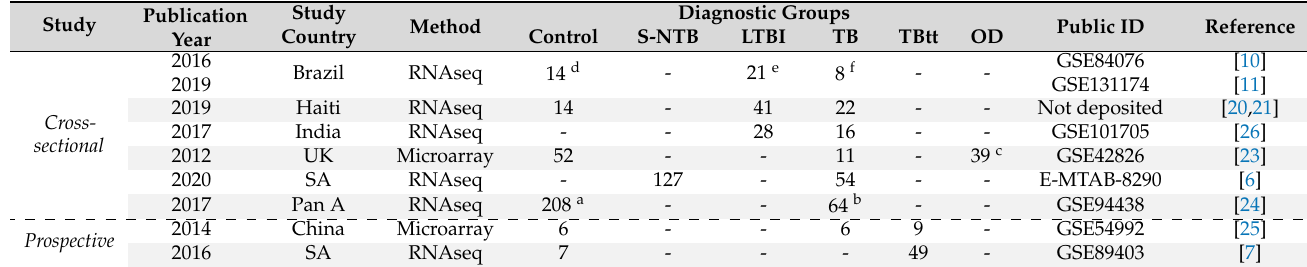
Table 1. Overview of the included